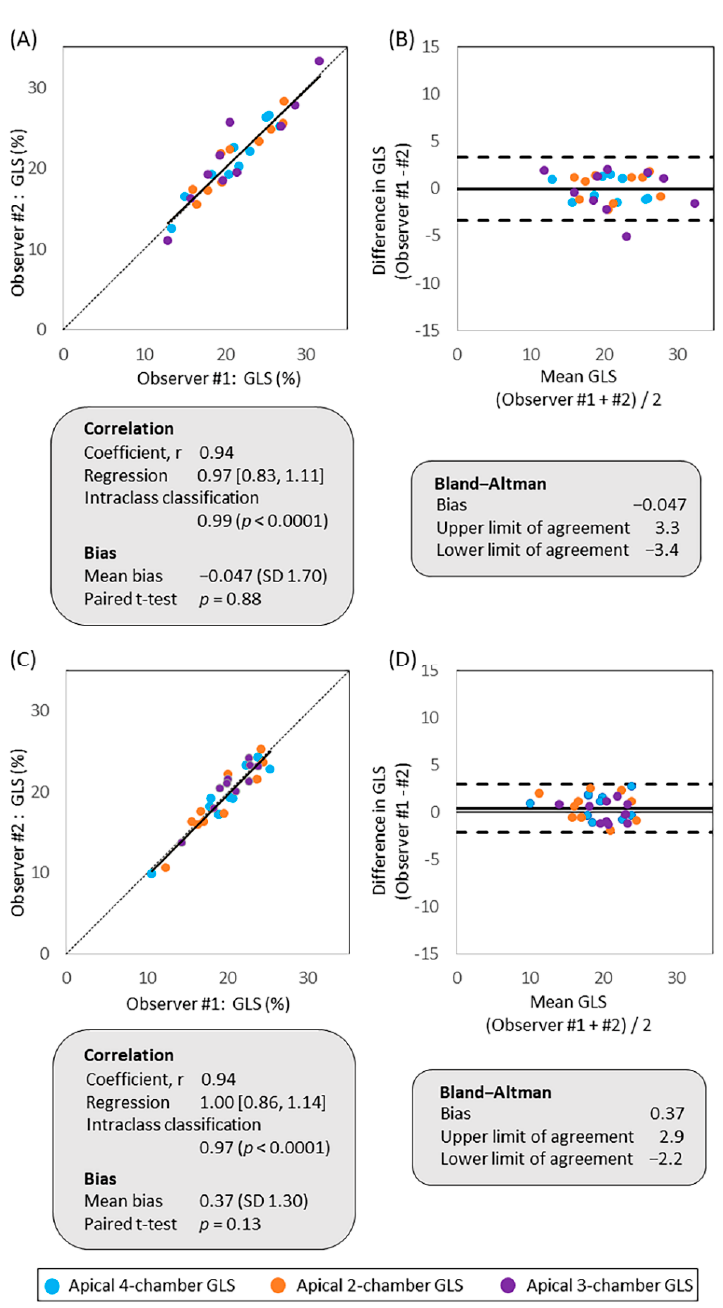
Figure 3. Inter-observer variability in apical 4-, 2-, and 3-chamber views. Reproducibility and agreement of absolute GLS values measured by observer #1 and #2 were compared using linear regression and Bland–Altman plots in ( A , B ) rHi-FR and ( C , D ) Reg-FR. GLS, global longitudinal strain; rHi-FR, relatively high frame rate; Reg-FR, regular frame